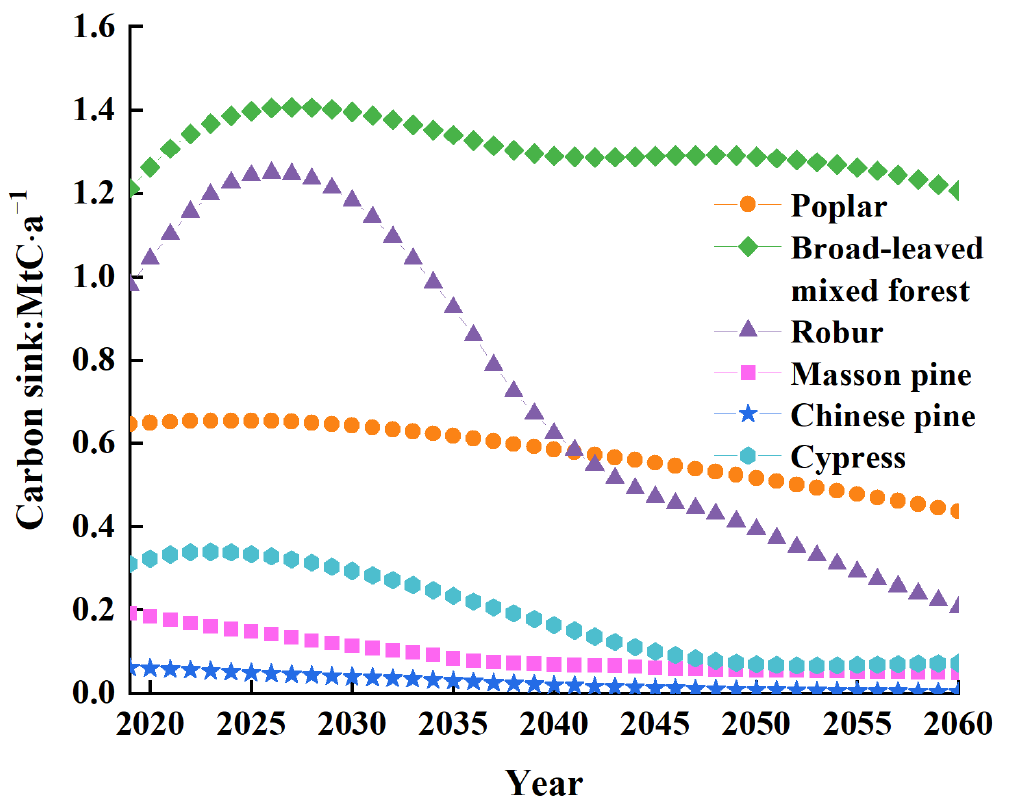
Figure 3. Carbon sinks in public welfare forests of dominant tree species in Henan Province, 2019– 2060.